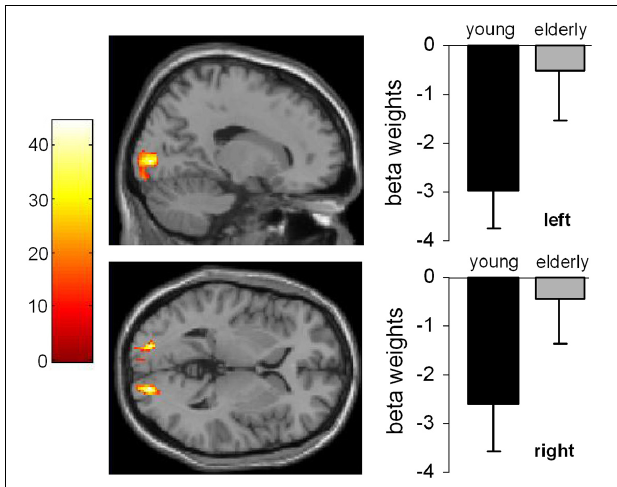
FIGURE 2 | Main effect of age. The left part of the Figure shows the activated brain areas ( p < 0 . 001; k > 30 voxels). The right part of the figure denotes the signal intensities (beta weights) mean and standard